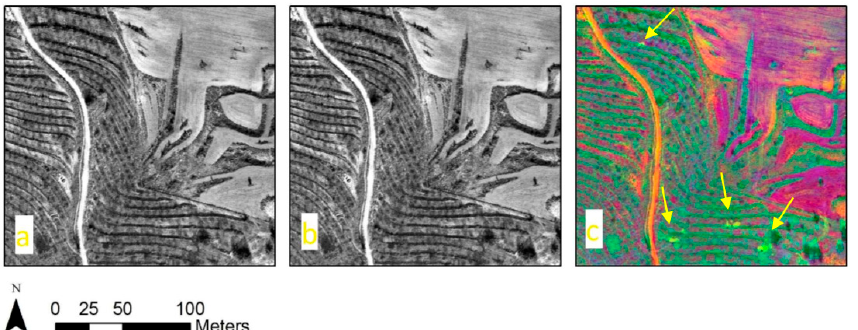
Figure 6. Principal component analysis results of the seven-band multi-temporal aerial datasets of 1993, 2008, and 2014: ( a ) Principal Component 1 (PC1); ( b ) Principal Component 2 (PC2); and ( c ) the pseudo-color composite of the first three principal components (PC1–PC3). Looted marks are indicated with arrows.